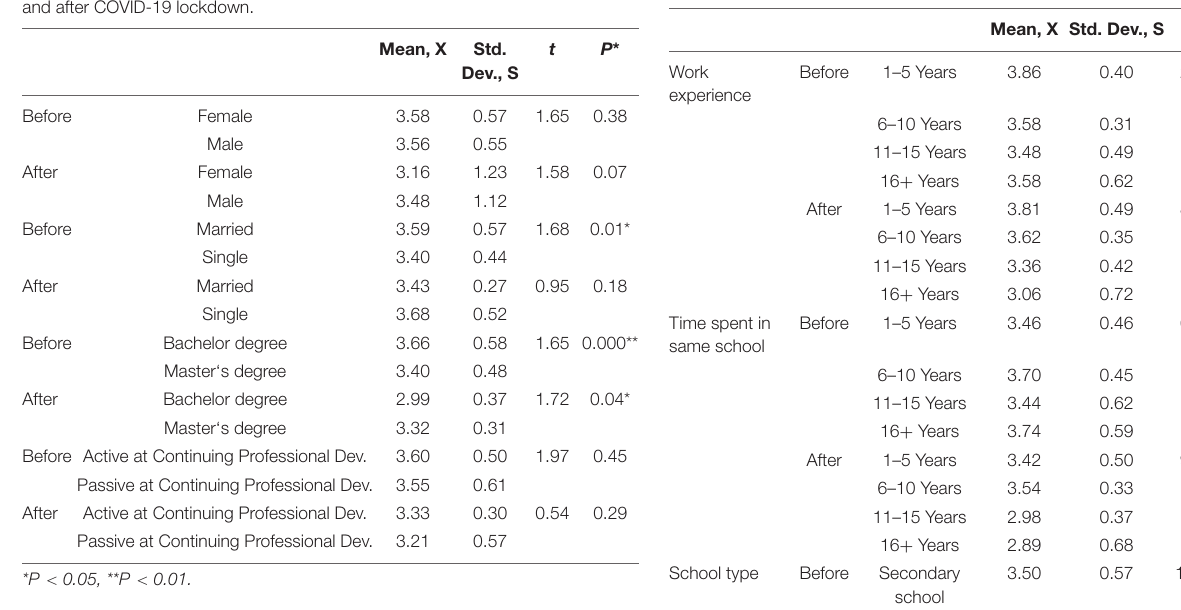
TABLE 3 | T -test results of organizational commitment levels of teachers before and after COVID-19 lockdown.